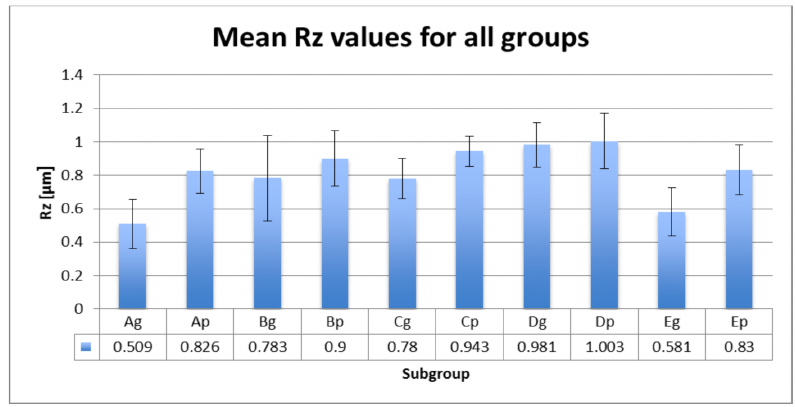
Figure 6. Rz values (mean ± SD) for all tested groups.